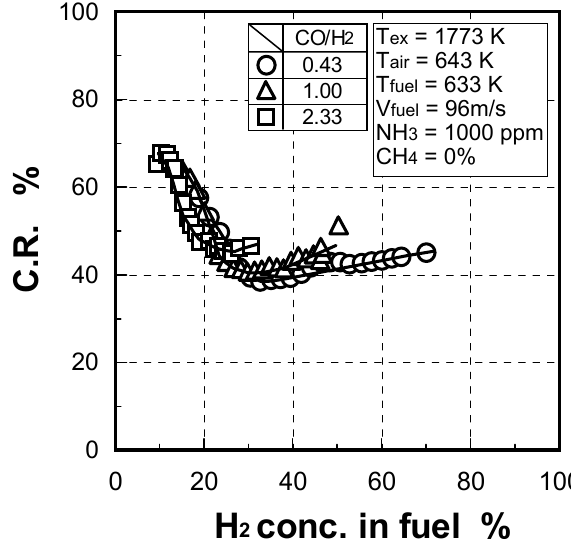
Figure 14. Effects of H Figure 13 was